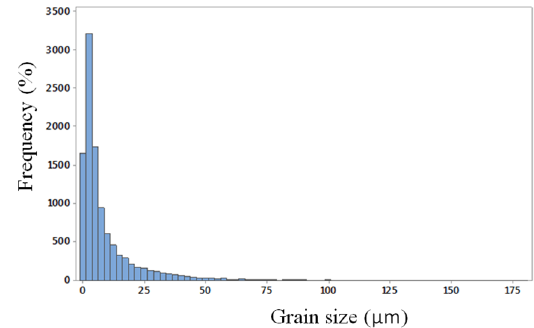
Figure 7. EBSD phase map for the supermartensitic steel samples after tempering for 30 min at a temperature range of 600-640°C. Figure 8. Grain size distribution (µm) of the tempered SMSS